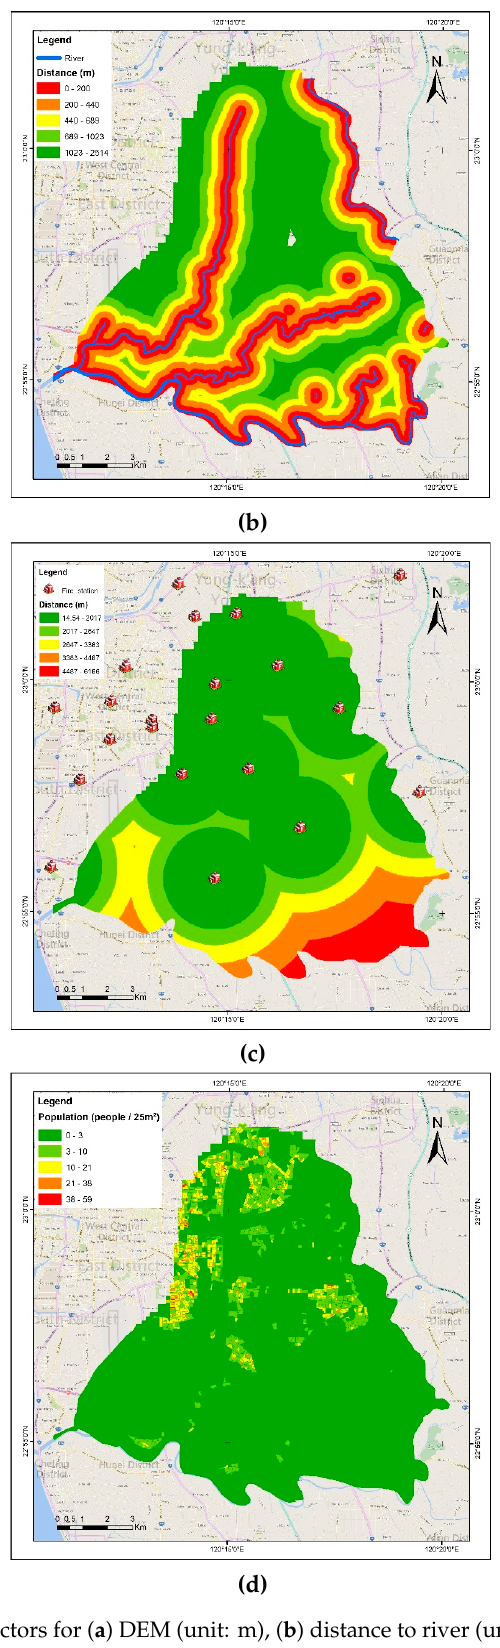
Figure 5. Vulnerability factors for ( a ) DEM (unit: m), ( b ) distance to river (unit: m), ( c ) distance to fire station (unit: m), and ( d ) population density (unit: persons / 25 m 2